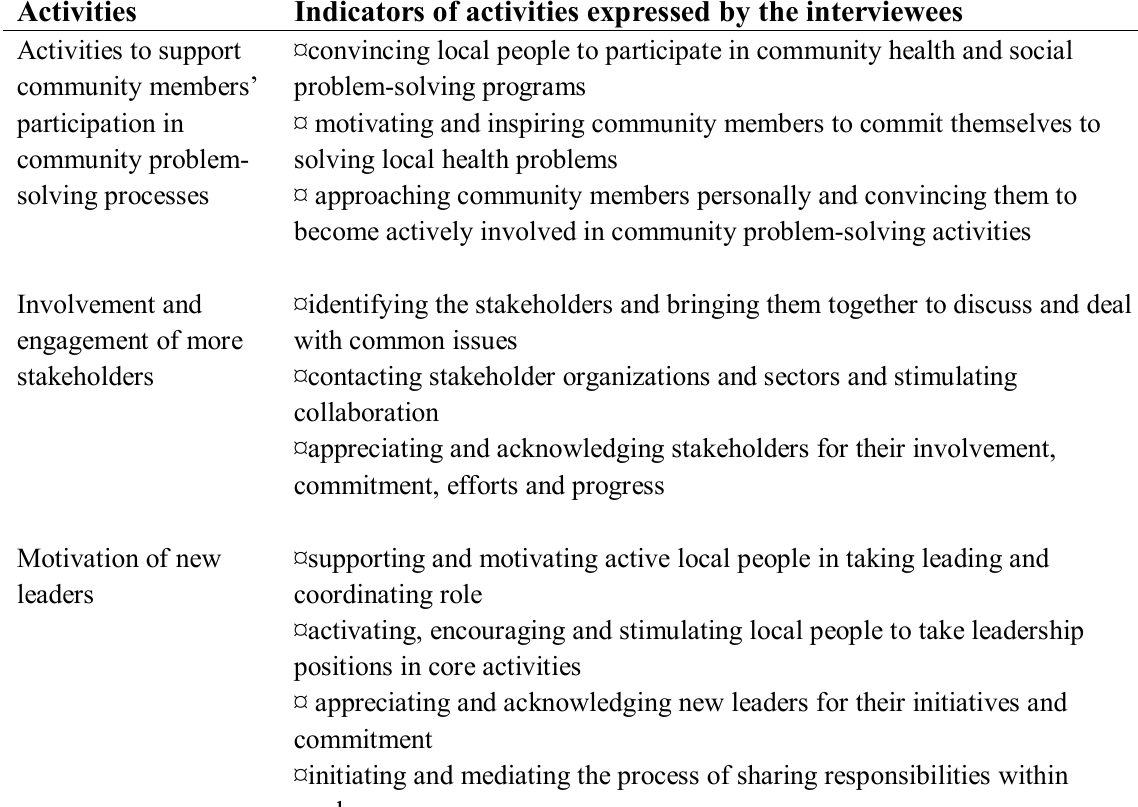
Table 4. Activities and indicators of activities expressed as empowering by the interviewees within the domain of Community